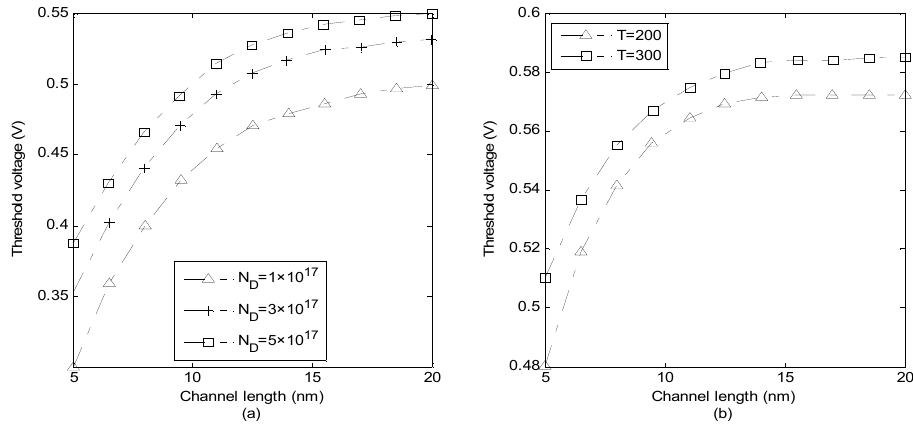
Figure 6. ( a ) Threshold voltage versus channel length for different ( a ) doping concentrations ( b ) temperatures. ( b )